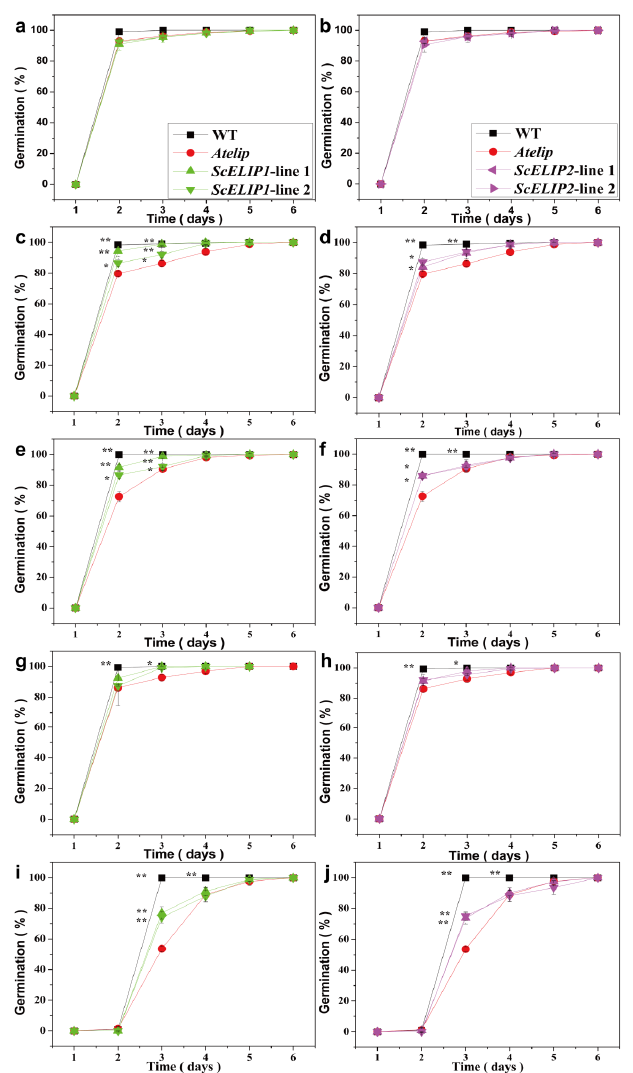
Figure 3. Seed germination rate for Col-0 WT ( Arabidopsis thaliana L. cv. Columbia), Atelip mutant, and 35S-ScELIP lines under different light treatments. The graphs depict germination rates over six days exposure to the different light regimes: Control condition ( a , b ), Red-light alone ( c , d ), Blue-light alone ( e , f ), UVB light alone ( g , h ), High-light irradiation (1500 µ mol / m 2 / s, i , j ). Error bars represent the SD (standard deviations) of three biological repeats. * p < 0.05; ** p < 0.01. P-values were obtained from Dunnett’s T3 test comparing WT and the transgenic lines with the Atelip mutant, respectively. First set, 35S-ScELIP1 line 1 and line 2; Second set, 35S-ScELIP2 line 1 and line